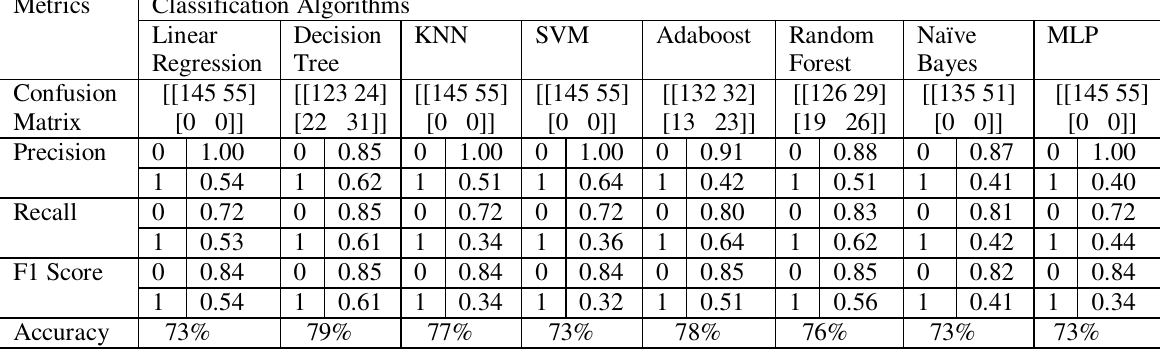
Table 2: Confusion matrix, Accuracy, Precision, Recall, and F1 score